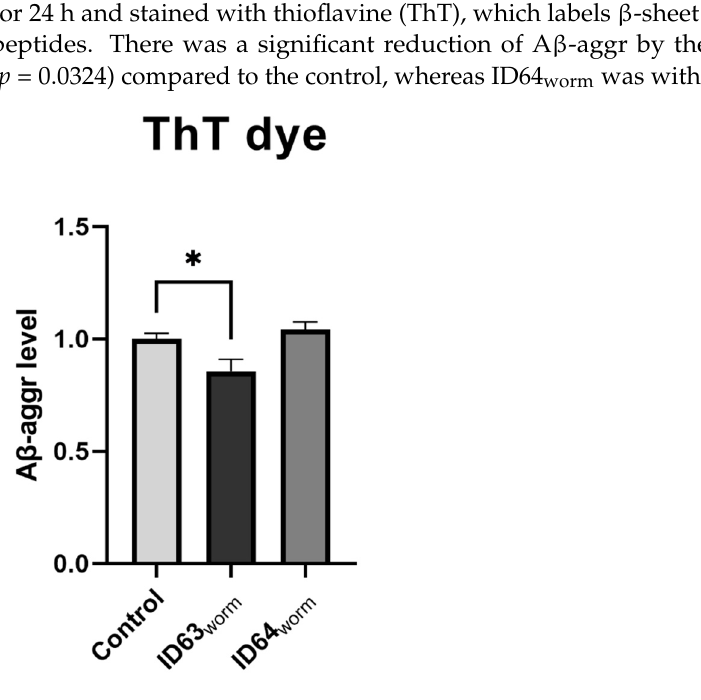
Figure 9. Effect of ID63 and ID64 in transgene nematodes GMC101 compared to the controls on the A β 1–42 level after 48 h incubation. Neither ID63 nor ID64 did not lead to a significant alteration of A β 1–42 . N = 8. A β 1–42 levels were adjusted to the protein content. N = 8. Mean ± SEM. Student’s t -test. ID63 worm = Fol 50 µM and MgOr 100 µM; ID64 worm Fol 50 µM, MgOr 100 µM and Vit B6 100 µM.